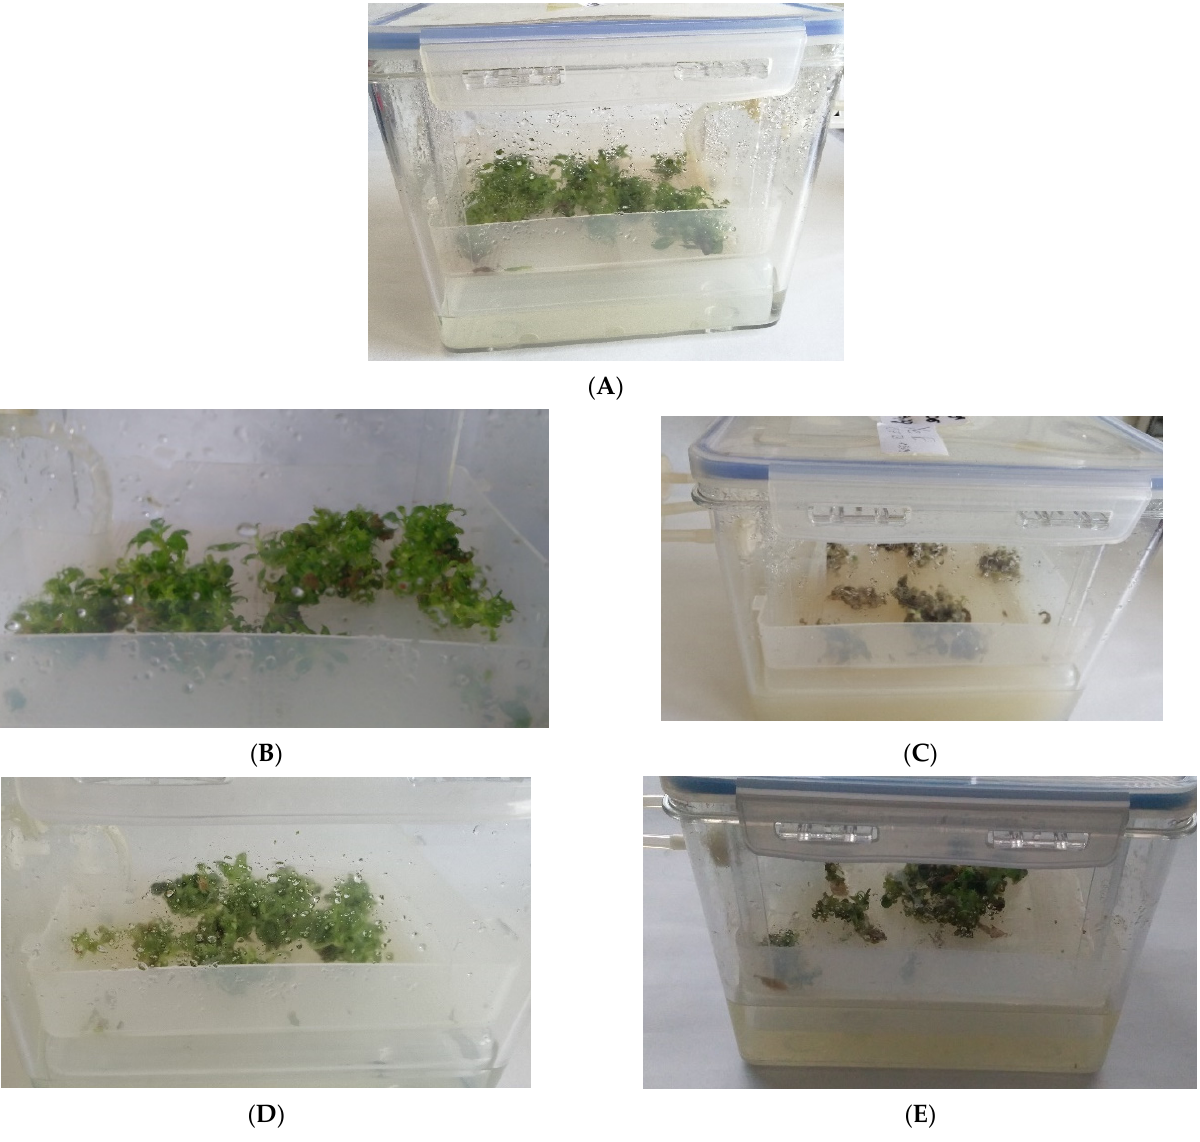
Figure 2. Biomass appearance of control and elicited in vitro cultures of S. rubriflora line M